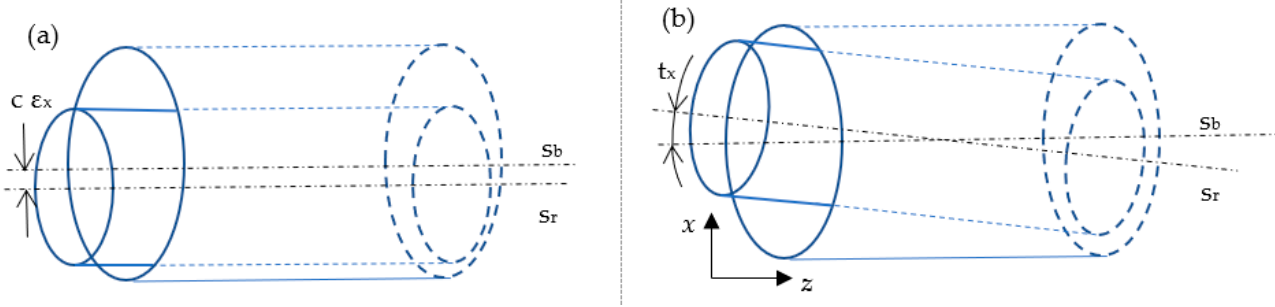
Figure 1. Two spindle motion modes: ( a ) eccentricity; ( b ) tilting. s b and s r denote the bearing and rotor axes, respectively.